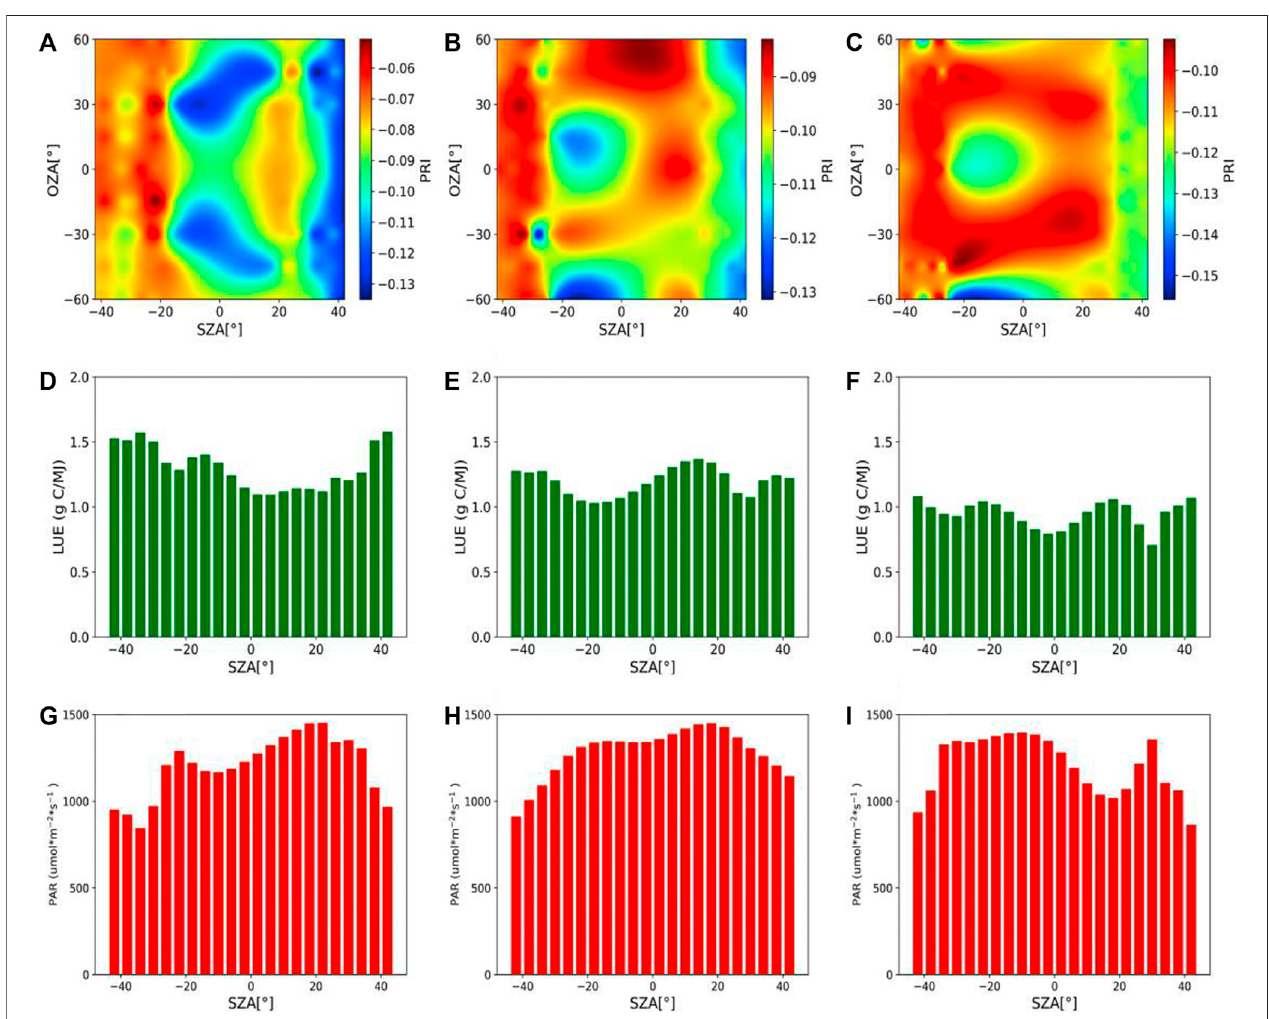
FIGURE 4 | Daily multi-angle-PRI (A – C) , LUE (D – F) , and PAR (G – I) of the canopy during rice growth. Three times were selected as representative periods of rice growth [ (A – I) represent 9:00 – 15:00 in August 10, August 29, and September 12, 2018, respectively]. The x -axis isthe SZA; the negative direction of which isbefore 12: 00. The negative direction of the left y -axis in (A – C) is the backscatter. The values between the measurements are linearly interpolated.